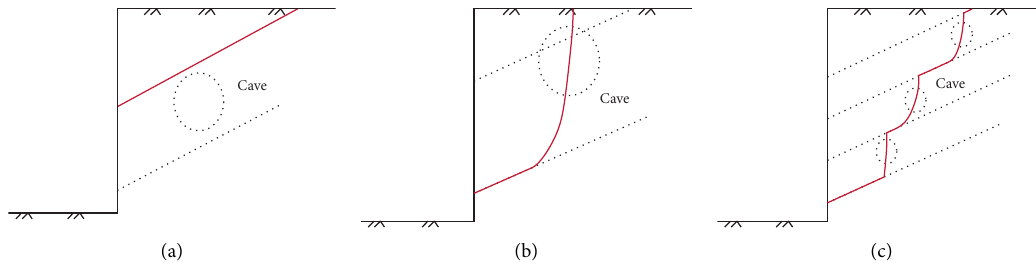
Figure 1: Schematic diagrams of the failure mode of a rock slope containing structural planes and karst caves (Figure 1 is reproduced from Jin Xu et al. 2021). (a) Single structural plane sliding failure. (b) Curved face-plane sliding failure. (c) Polyline sliding failure between multiple structural planes.